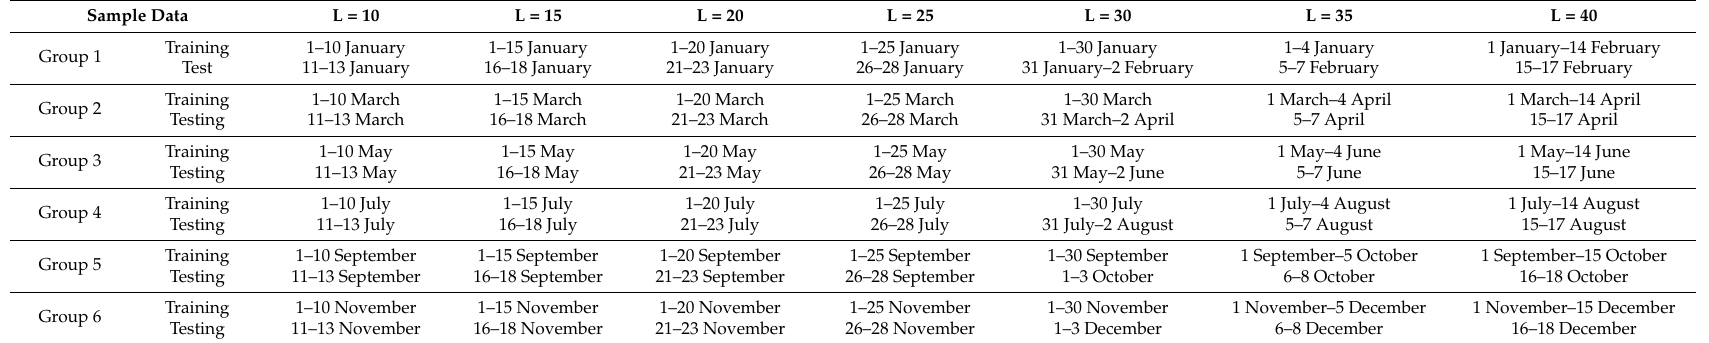
Table 1. Selection of experimental data.